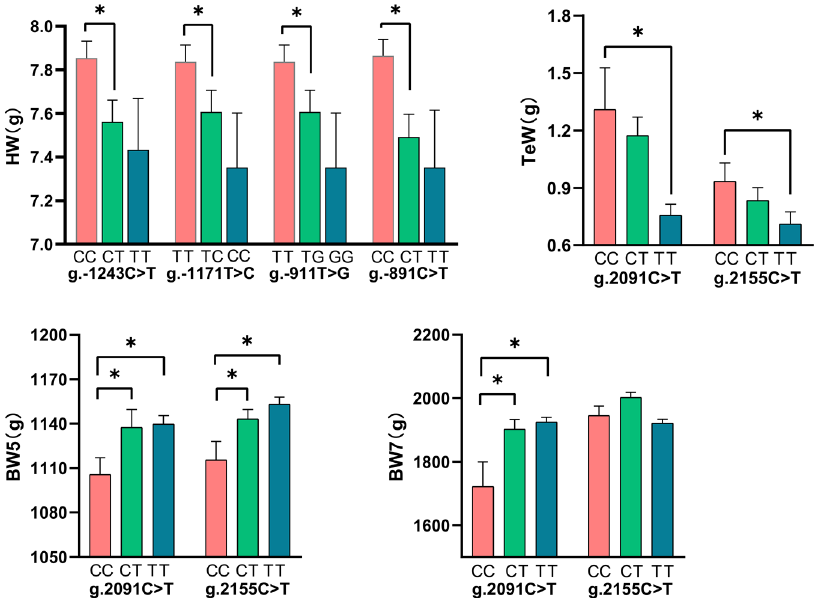
Figure 4. Analysis of the phenotypes of different genotypes of functional SNPs. * indicates a significant difference, p < 0.05.